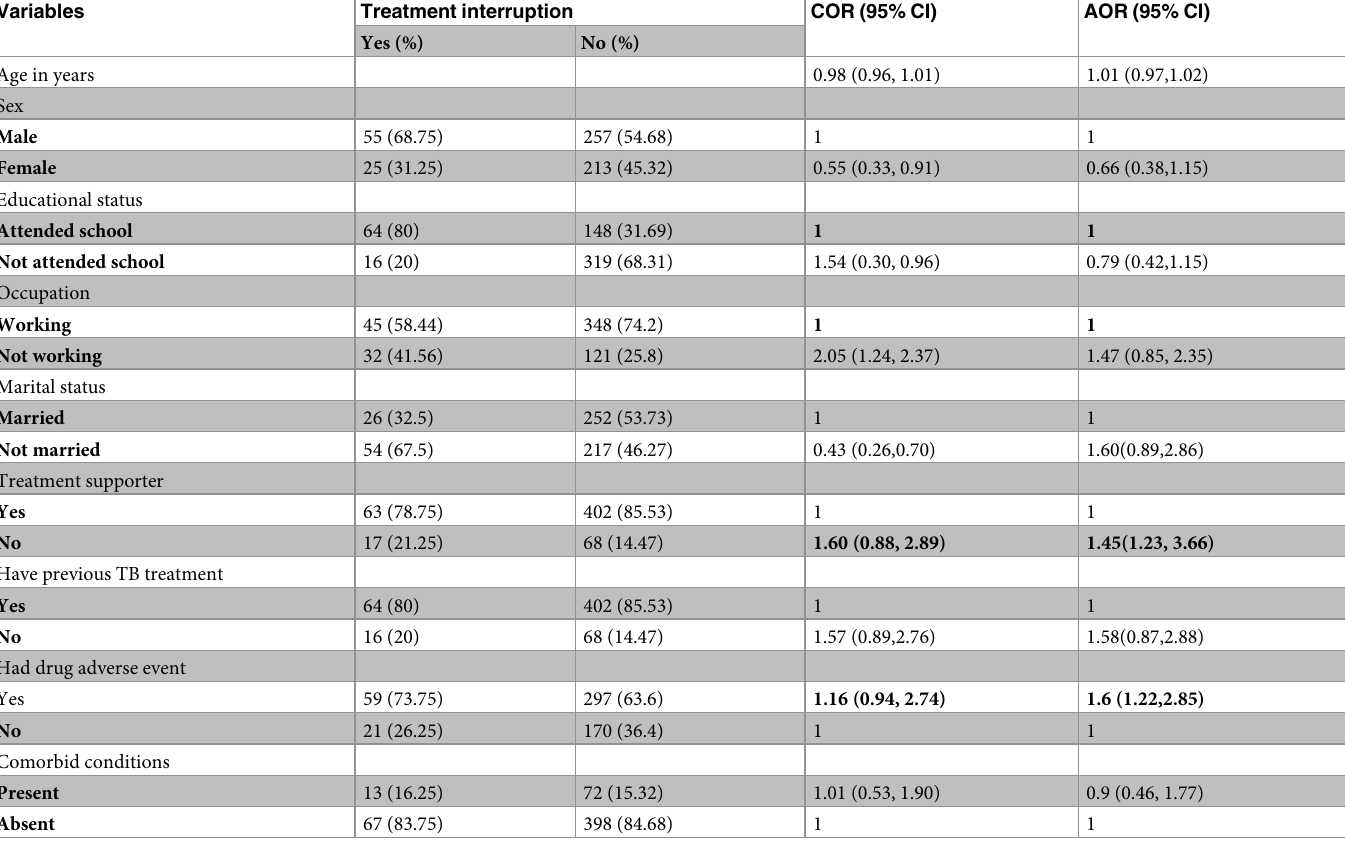
Table 2. Bi-variable and multi-variable binary logistic regression analysis of factors associated with treatment interruption among DR-TB patients in Amhara regional state, Ethiopia: 2010–2017 (N = 550).